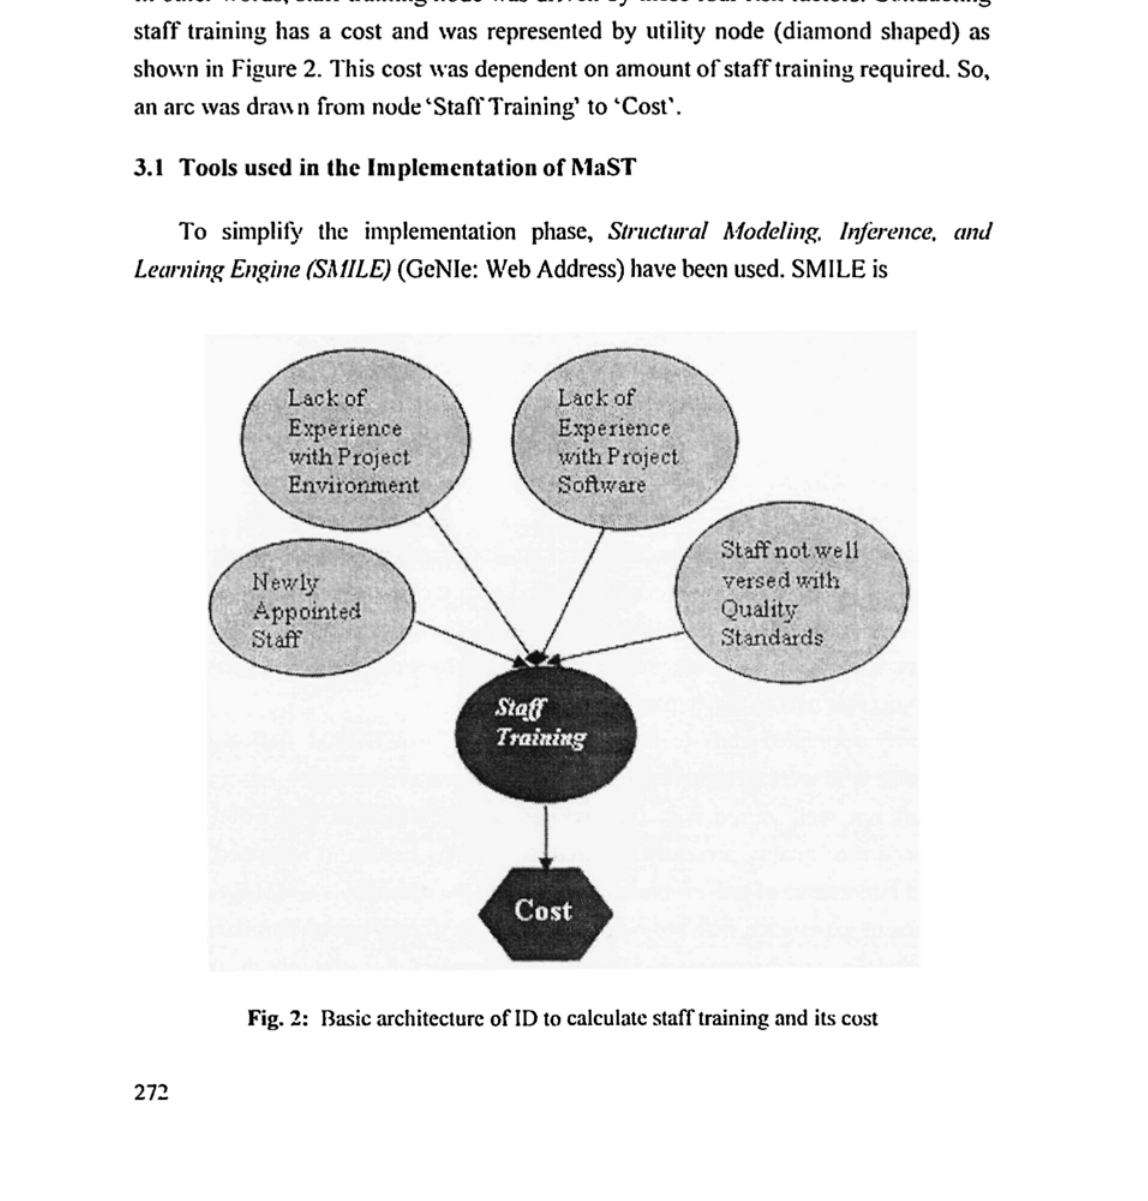
Fig. 2: Basic architecture of ID to calculate staff training and its cost